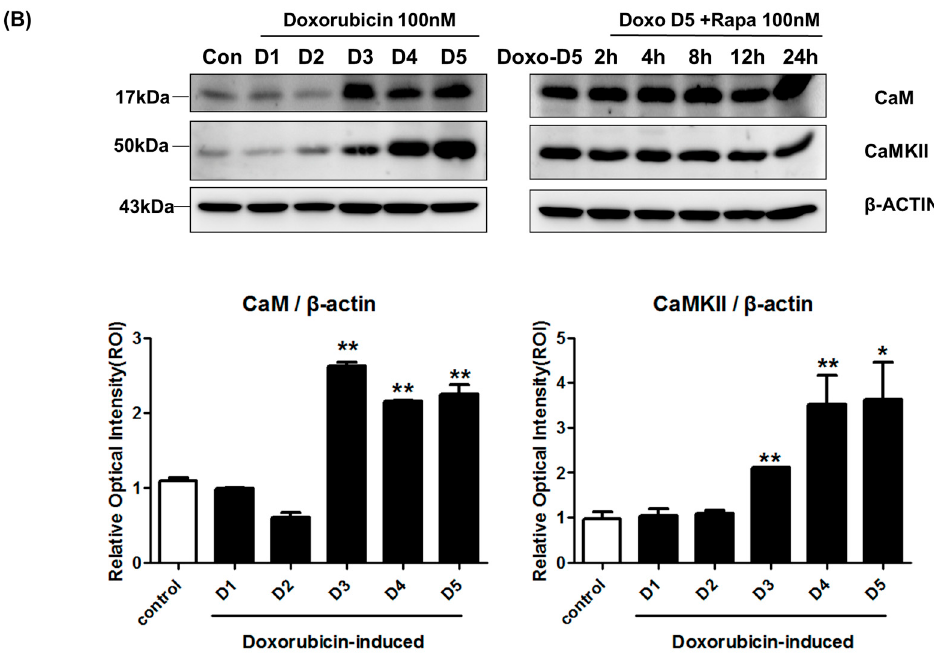
Figure 5. Rapamycin modulates cytosolic Ca 2+ accumulation. ( A ) After treatment of hCPCs with doxorubicin (100 nM, 5 days) with rapamycin (100 nM, 12 and 24 h), intracellular Ca 2+ levels were analyzed by Fluo-8 assay. The quantitative values of fluorescence intensity are presented. DOXO: doxorubicin, Rapa: rapamycin, ** p < 0.01 versus control; ## p < 0.01 versus DOXO-treated group; ( B ) After treatment of hCPCs with doxorubicin in a time-dependent manner (DOXO: 100 nM) and/or rapamycin (DOXO: 100 nM, 5 days), the expression of CaM and CaMKII was examined by Western blot analysis. * p < 0.05 versus control; ** p < 0.01 versus control.